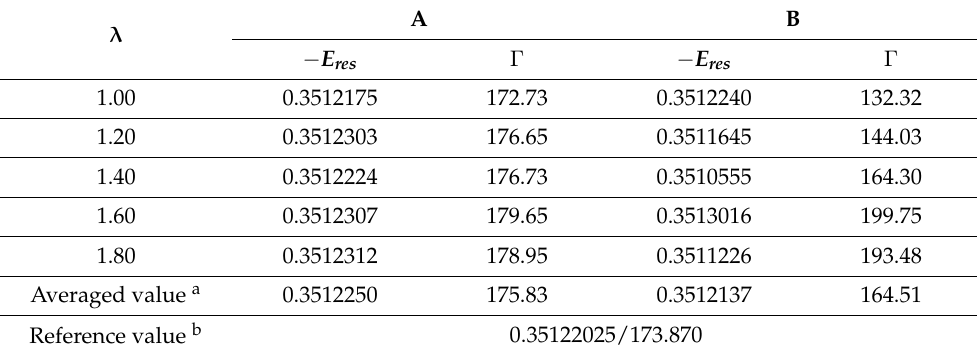
Figure 7. CAP-trajectories in the vicinity of the first ( a ) and the second ( b ) 2 P 0 resonance of Li atom for the different values of the scaling factor λ (26), i.e., ○ —λ = 3.1, □—λ = 3.3, ◊—λ = 3.5, ∆ — λ = 3.7. The horizontal line in panel ( a ) corresponds to the experimental value of the resonance width [51,53]. Sign + in panel ( b ) indicates the position of the calculated resonance [54]. Data are presented in a.u. Table 4. Energy (a.u.) and width ( × 10 − 5 a.u.) of the lowest 1 S resonant state of H − . Case A: averaging over a closed trajectory section. Case B: search for an optimal